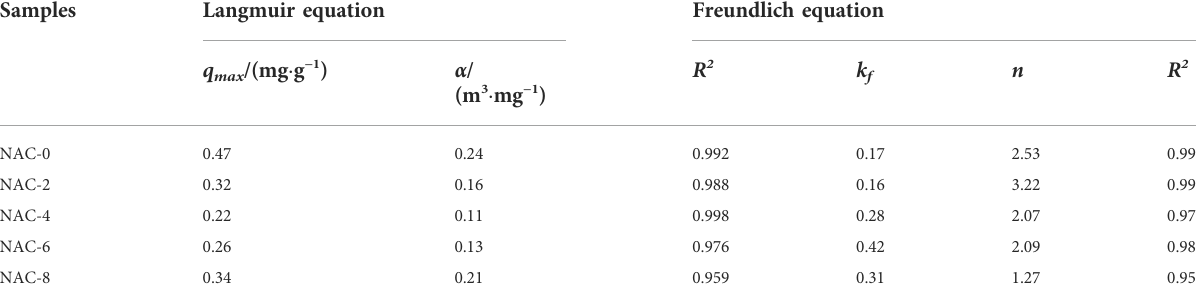
TABLE 3 Fitting parameters of Langmuir equation and Freundlich equation.